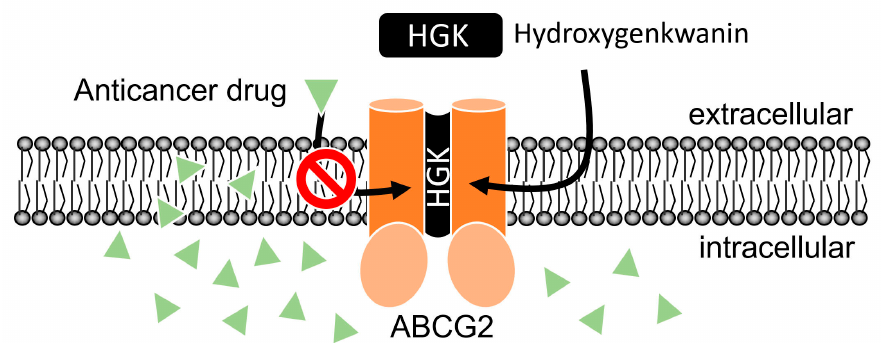
Figure 8. A schematic illustration of hydroxygenkwanin (HGK) reversing ABCG2-mediated drug resistance in cancer cells by inhibiting the drug transport function of ABCG2. HGK binds to the drug-binding pocket of ABCG2 and competes with the binding of substrate anticancer drugs of ABCG2 (green triangles), resulting in elevated intracellular concentration and the cytotoxicity of anticancer drugs in ABCG2-overexpressing multidrug-resistant cancer cells.